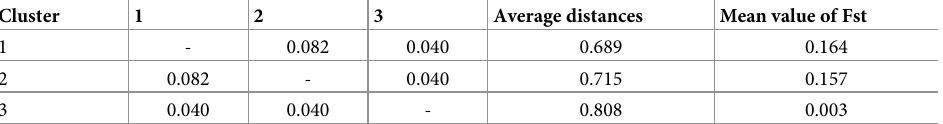
Table 4. Allele-freq. divergence (Net nucleotide distance), computed using point estimates of P through Structure analysis.